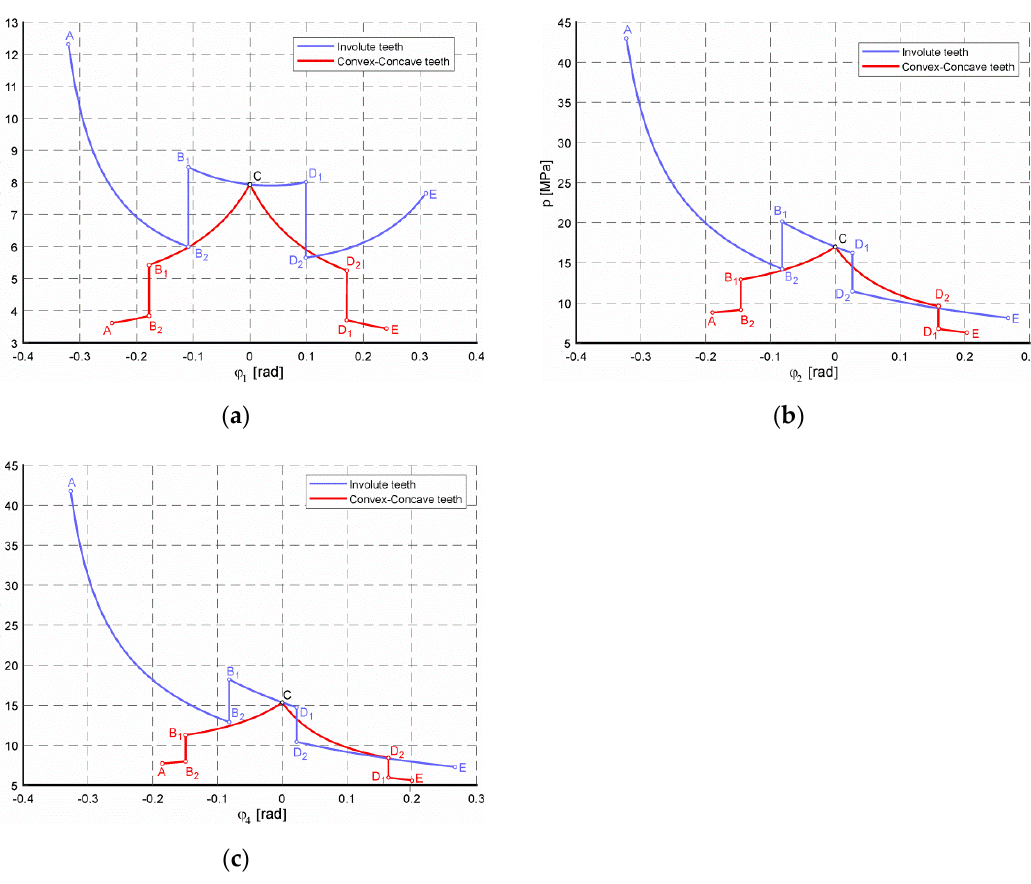
Figure 8. Hertzian pressure p , which depends on angle ϕ pinion in the gear pairs with involute and convex–concave teeth flanks: ( a ) gear pair 1-2, ( b ) gear pair 2-3, and ( c ) gear pair 4-5.